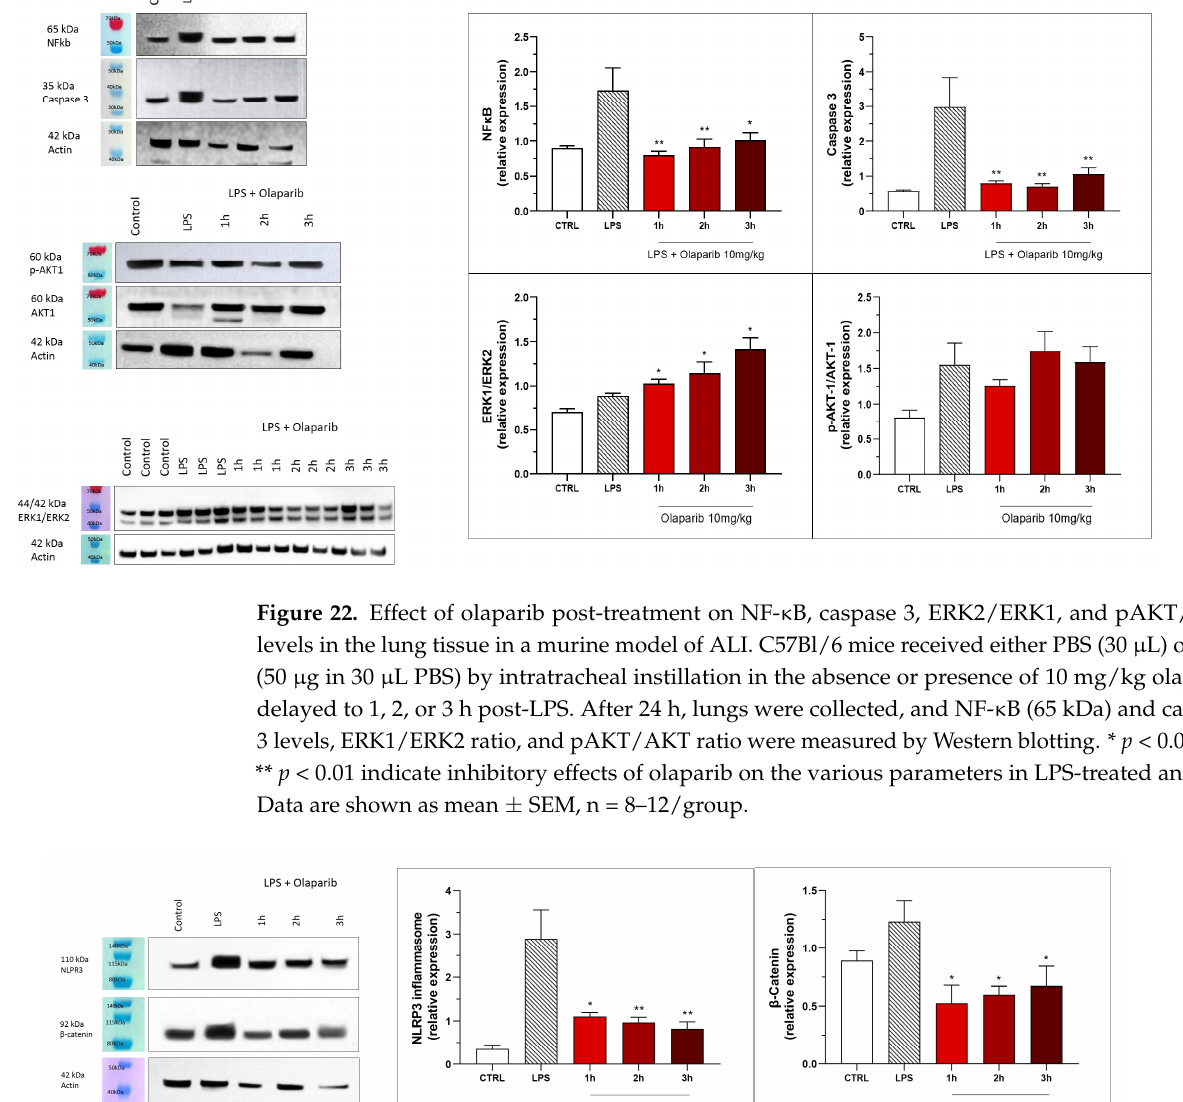
Figure 23. Effect of olaparib post-treatment on NLPR3 inflammasome activation and β -catenin expression in the lung tissue in a murine model of ALI. C57Bl/6 mice received either PBS (30 µ L) or LPS (50 µ g in 30 µ L PBS) by intratracheal instillation in the absence or presence of 10 mg/kg olaparib, delayed to 1, 2, or 3 h post-LPS. After 24 h, lungs were collected, and NLPR3 inflammasome activation and β -catenin expression were measured by Western blotting. * p < 0.05 and ** p < 0.01 indicate inhibitory effects of olaparib in LPS-treated animals. Data are shown as mean ± SEM, n =